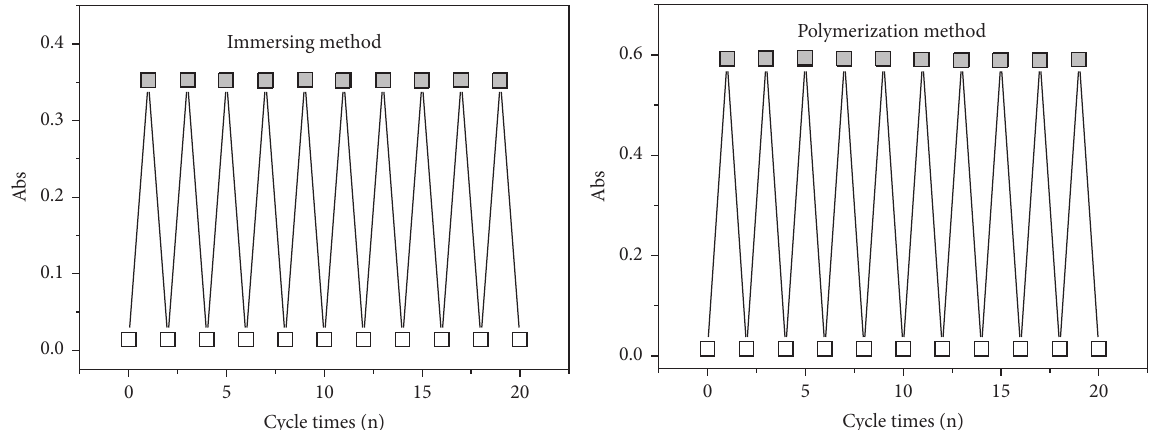
Figure 6: Fatigue resistance cycles of photochromic hydrogel by alternative irradiation: gray box at 𝜆 = 365 nm, and white box 𝜆 = 632